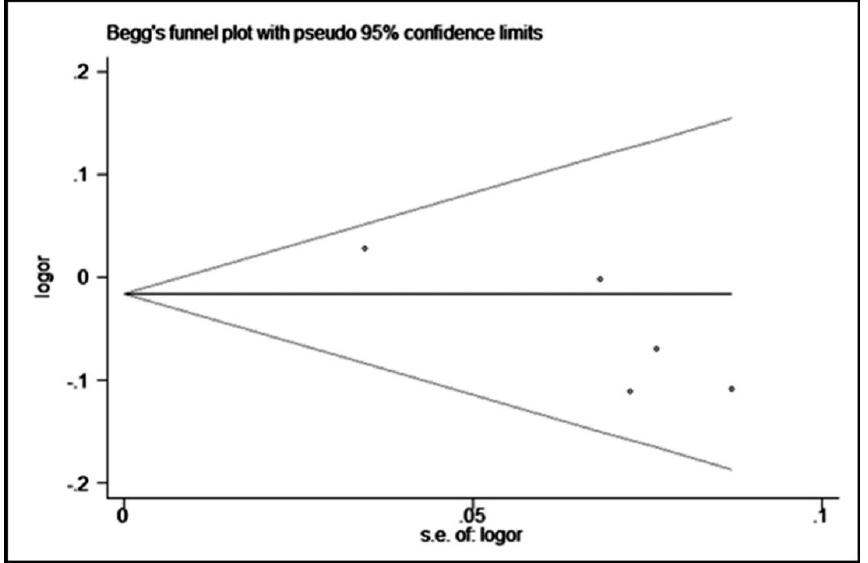
Table 3. Egger’s and Begg’s test for the publication bias of rs2275913.